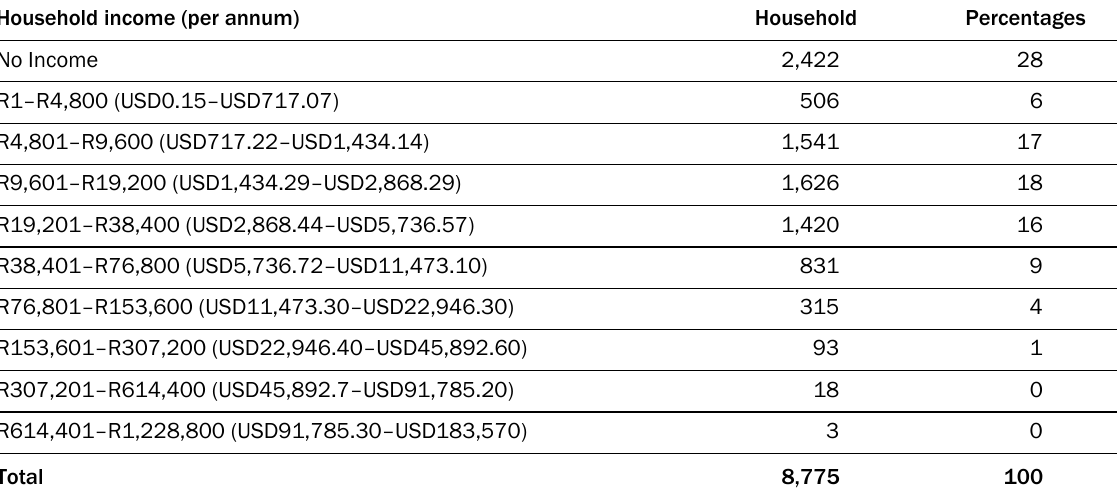
Table 1. Household Income Levels in KwaMashu Household income (per annum)